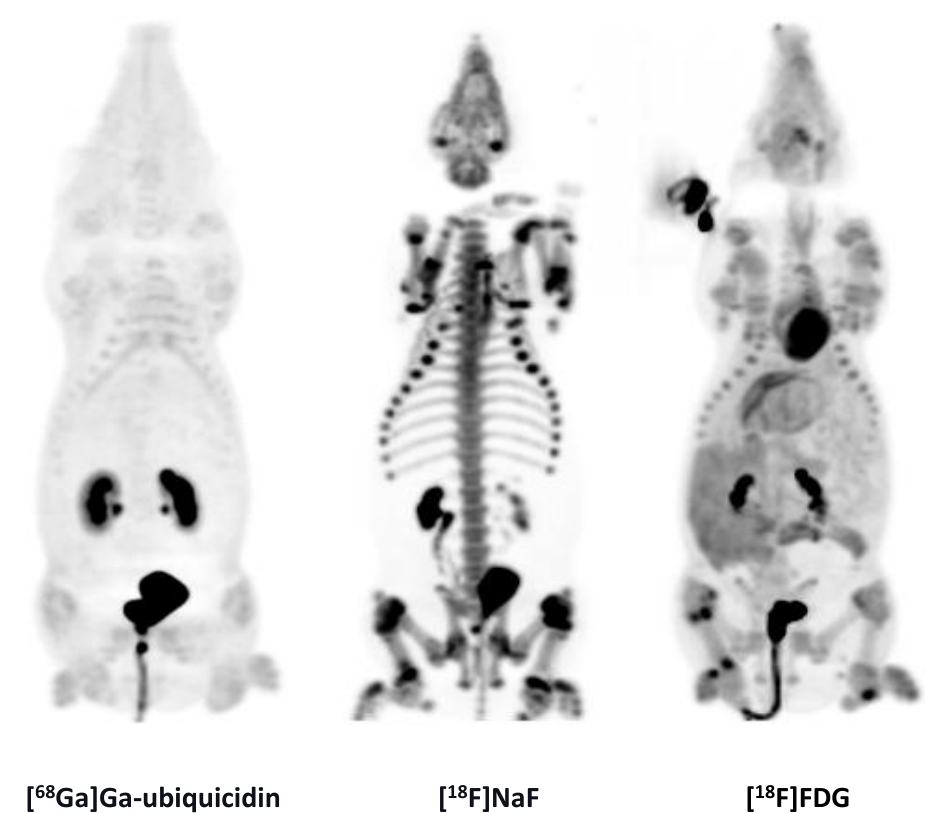
Figure 5. MIPs of [ 68 Ga]Ga-ubiquicidin, [ 18 F]NaF, and [ 18